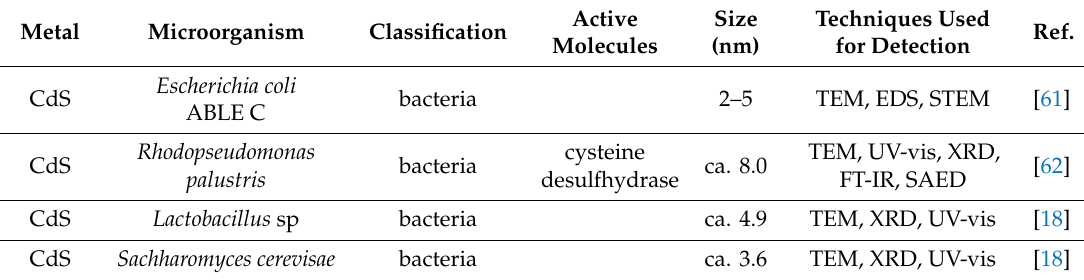
Table 3 lists the microorganism strains used for the synthesis of CdS NPs and the techniques used for their study. Table 3. List of microorganisms for synthesis of CdS nanoparticles and technique for confirmation of CdS